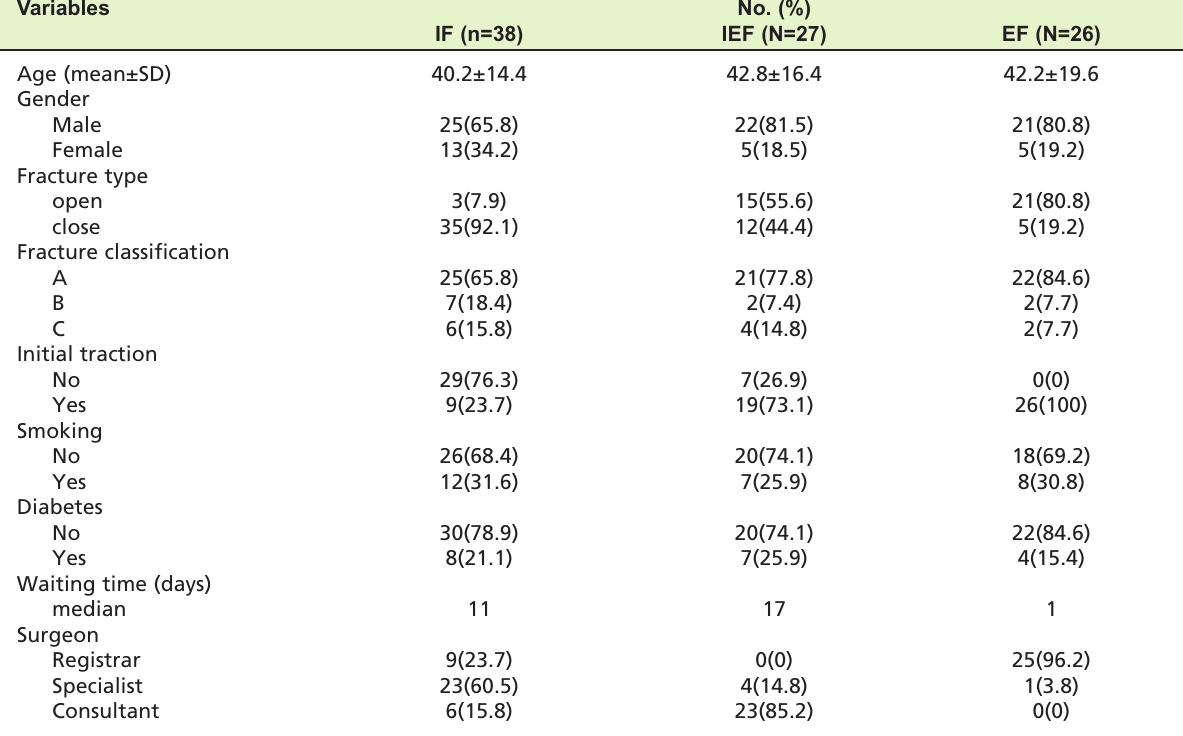
Background characteristics of patients (n=91) Table I: